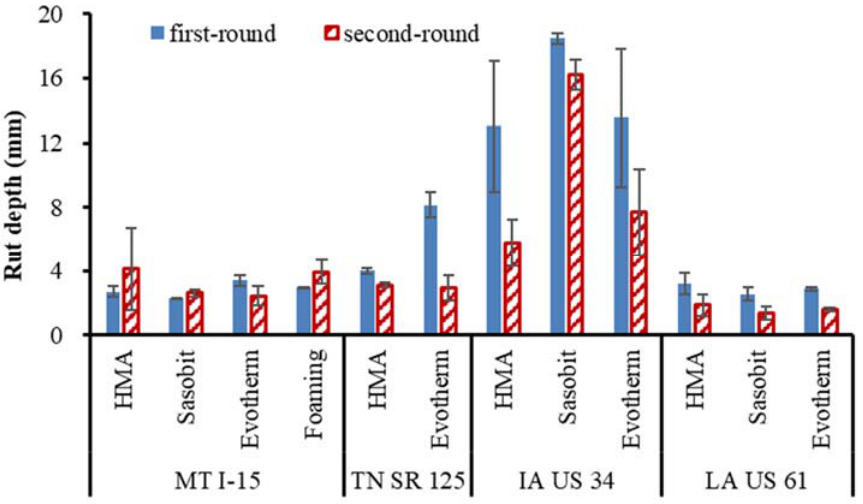
Figure 7. Comparisons of field core Hamburg rut depth.